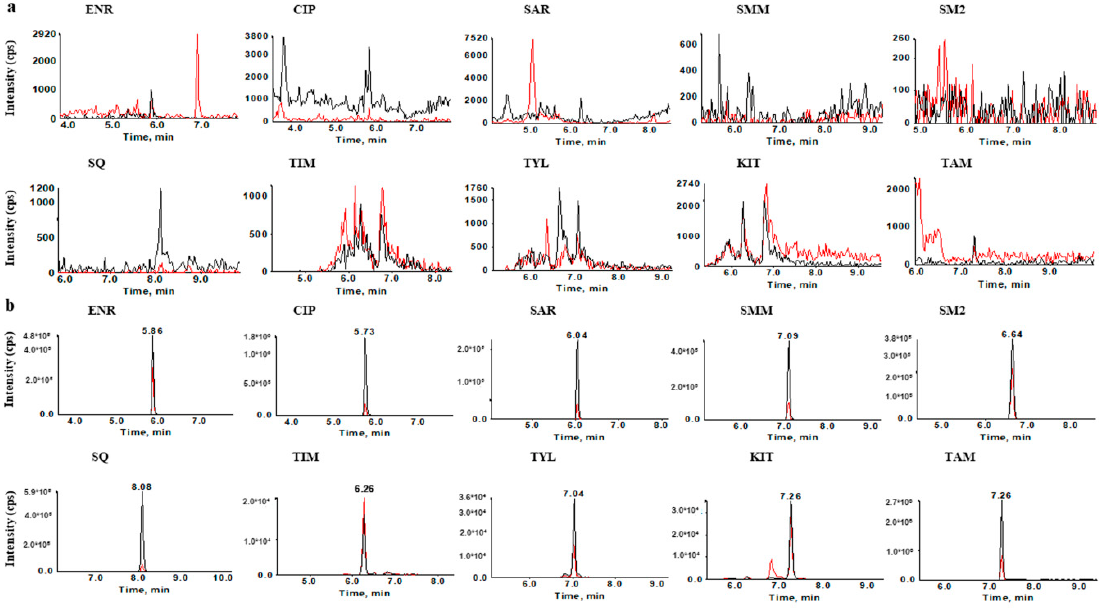
Figure 3. Typical SRM chromatograms of blank chicken muscle extracts ( a ) and its matrix-matched standard ( b ) (10 μ g L − 1 ). Blank line, quantification ion, red line, confirmation ion.